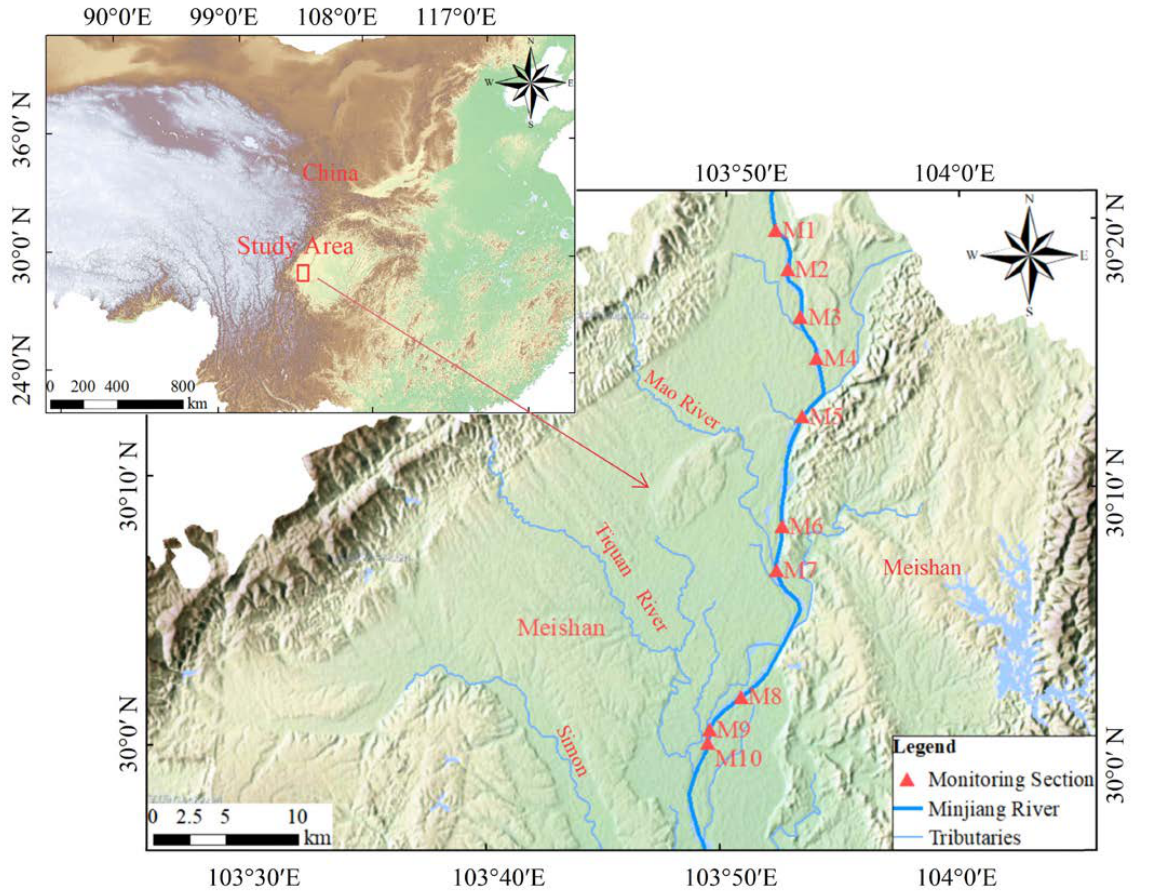
Figure 1. Location of the study area and distribution of monitoring sections.